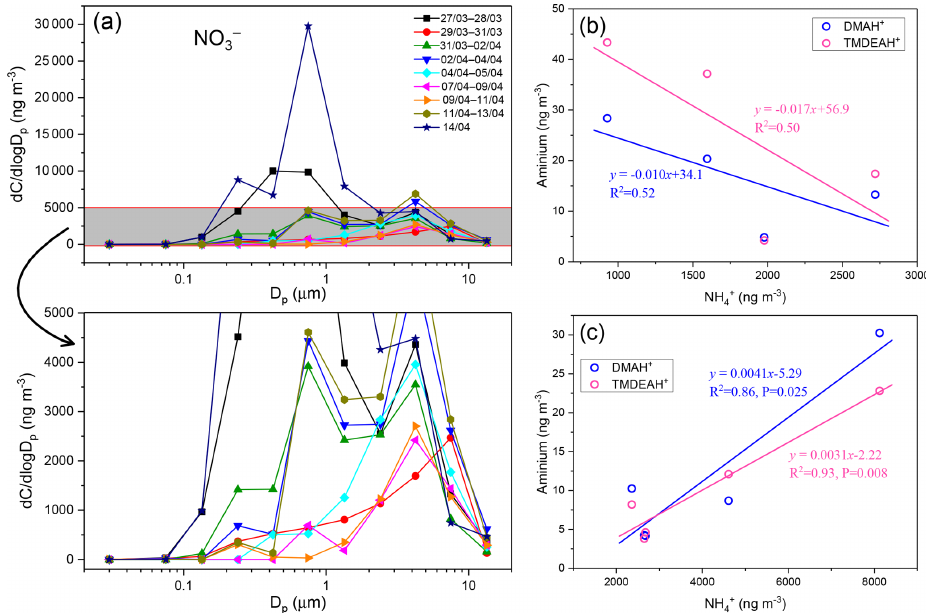
Figure 9. (a) Size distributions of NO − over the YECS in the spring of 2017. (b) Correlations between concentrations of aminiums and 3 NH + for the samples mainly influenced by marine air masses. (c) Correlations between concentrations of aminiums and NH + 4 samples predominantly influenced by terrestrial transport.